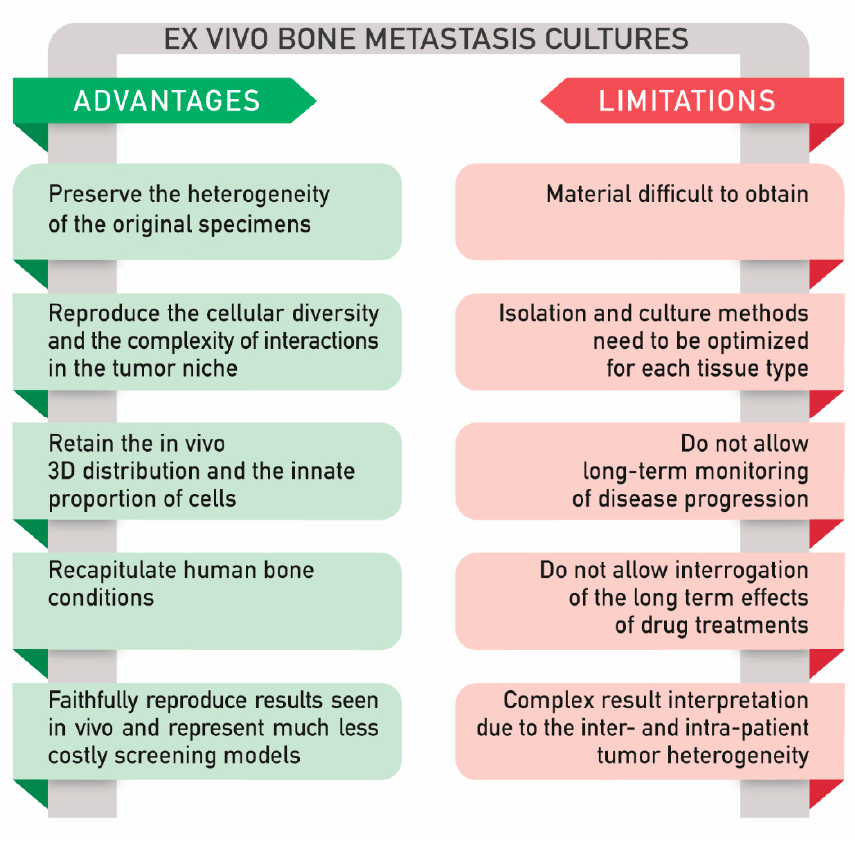
Figure 3. Ex vivo bone metastasis cultures, advantages, and limitations.